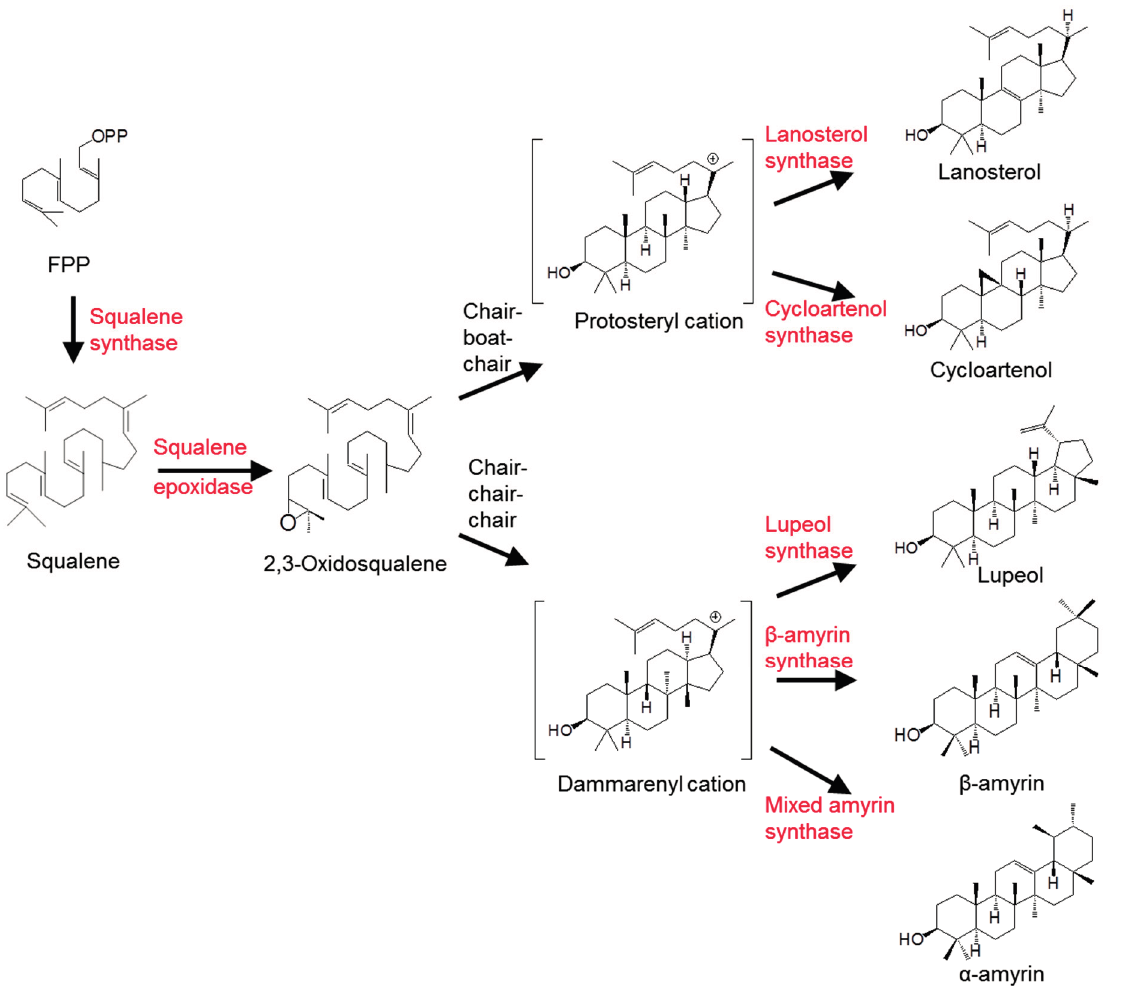
Figure 1. Biosynthesis of triterpenes catalysed by different types of oxidosqualene cyclase (OSC). Catalysed by a specific OSC, either protosteryl cation or dammarenyl cation could be formed according to different folding conformations of 2,3-oxidosqualene, leading to one or more final